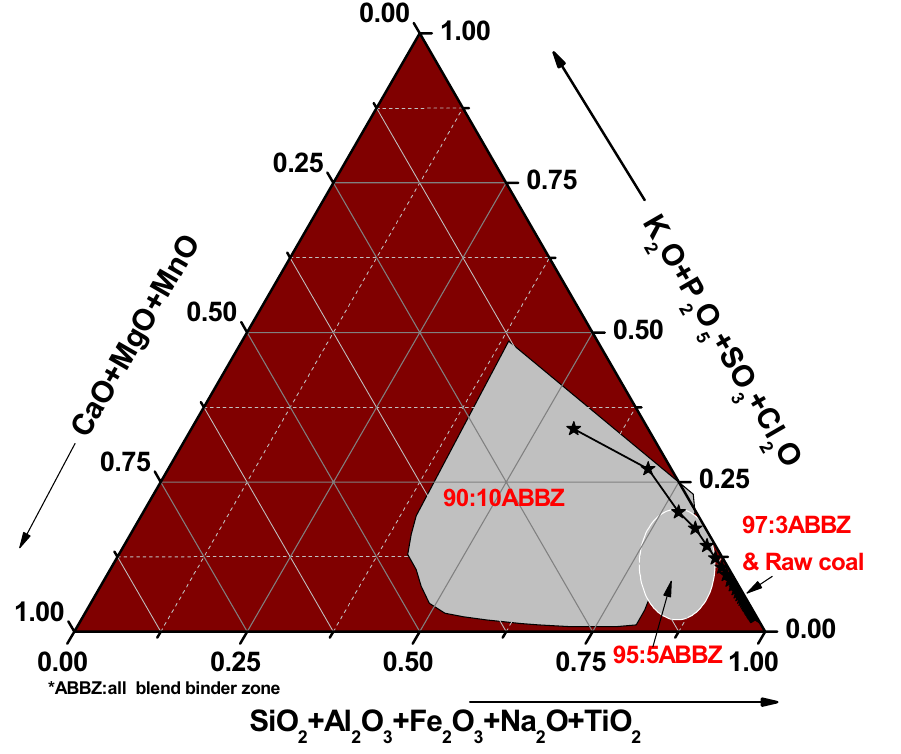
Figure 4. Area chemical classification of the hybrid briquette